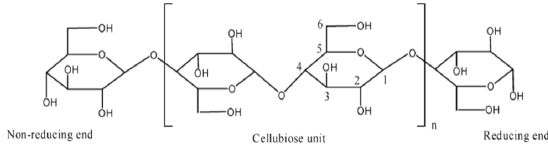
Figure 1. Cellulose molecule unit [14].